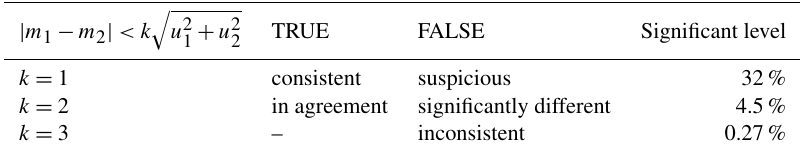
Table 5. Terminology for comparing pairs of independent measurements of the same quantification for consistency; excerpt from Sect. 2 of Immler et al. (2010).